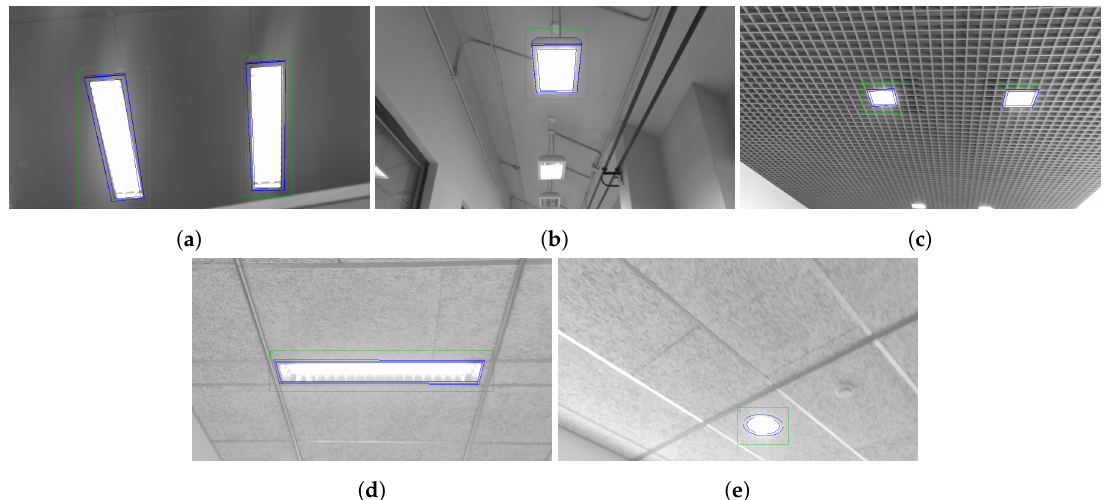
Figure 5. Detections for each of the case studies in the experiments: ( a – e ) Case studies 1 to 5.